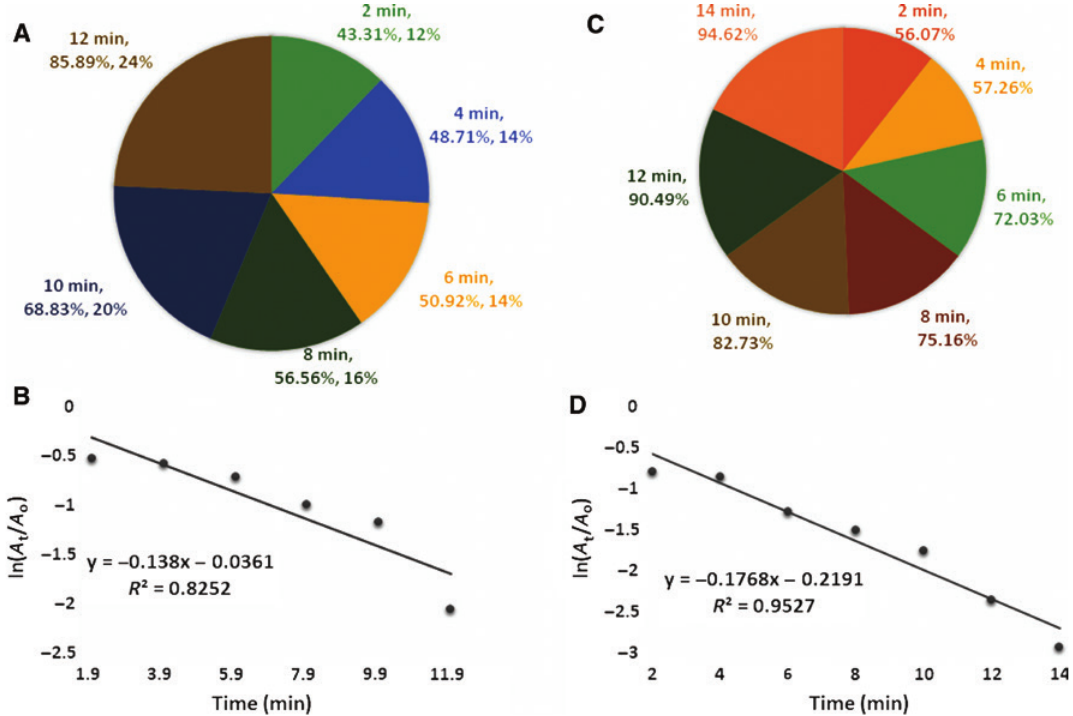
Figure 7: Photocatalytic degradation percentages and reaction kinetics: (A, C) bromocresol green and (B, D) bromophenol blue.